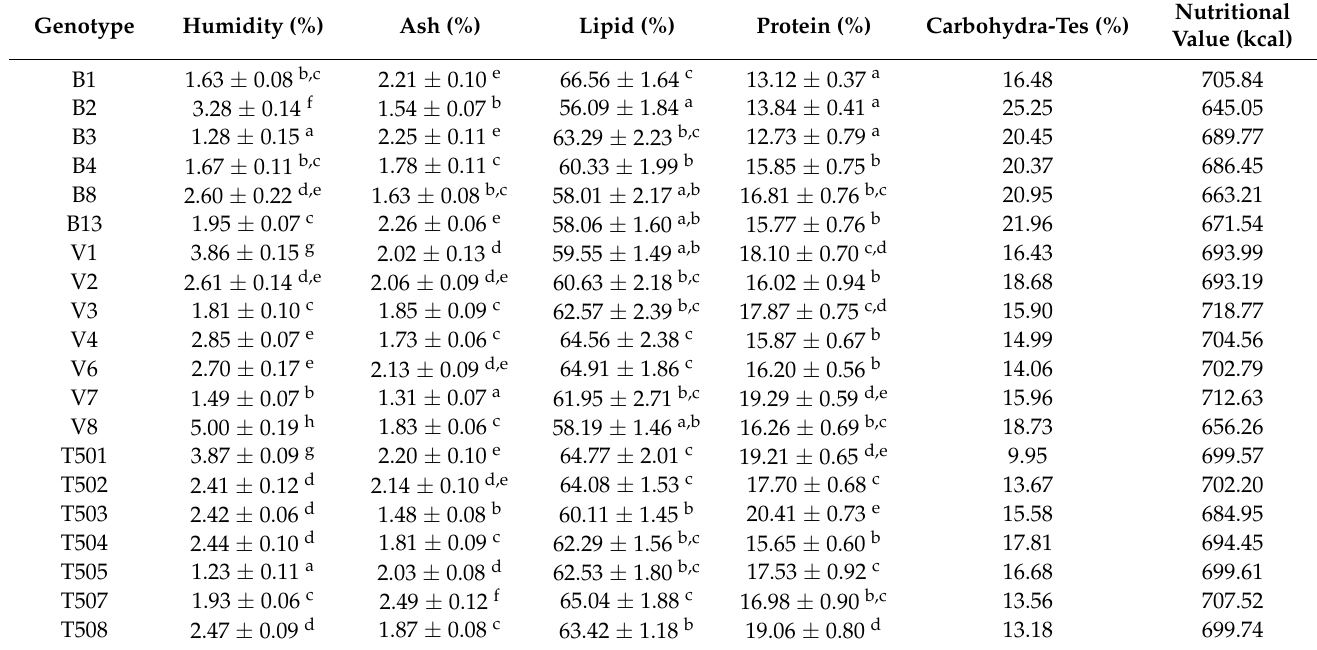
Table 5. Proximate composition of the walnut of different genotype from west and north-west of Romania.